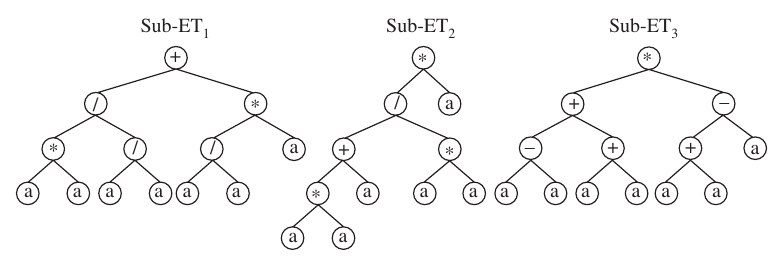
Figure 9 ET for the problem of Eq. (10).